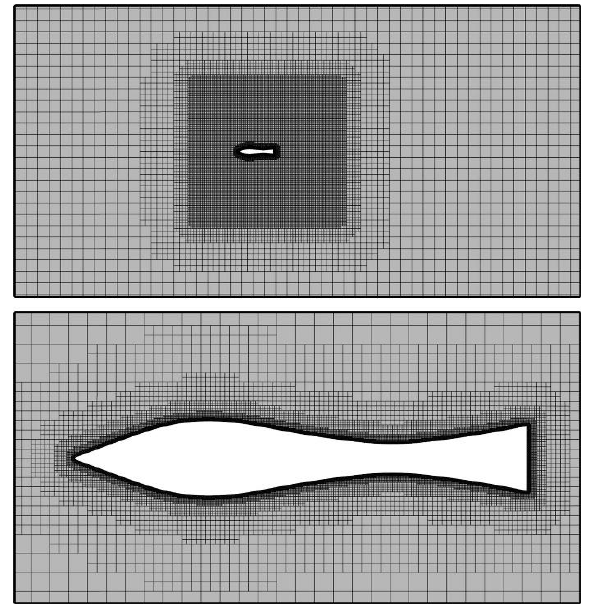
Figure 4. Grids distribution of the waisted body cases.